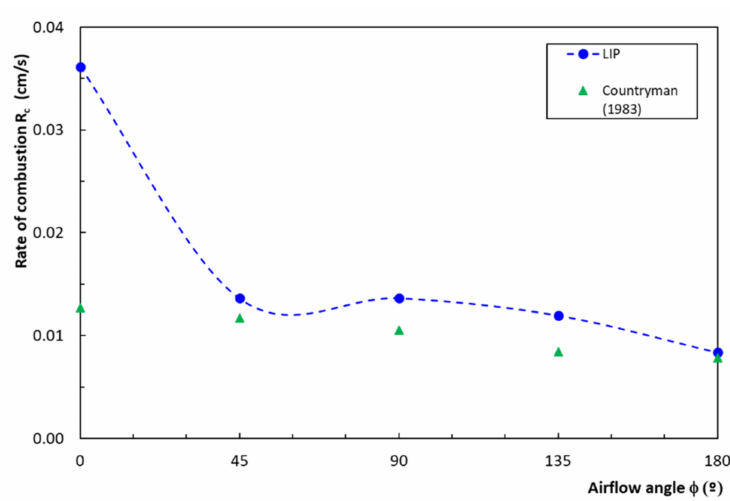
Figure 5. Variation of rate of combustion as a function of flow angle ϕ for LIP cigarettes for U = 2 m.s − 1